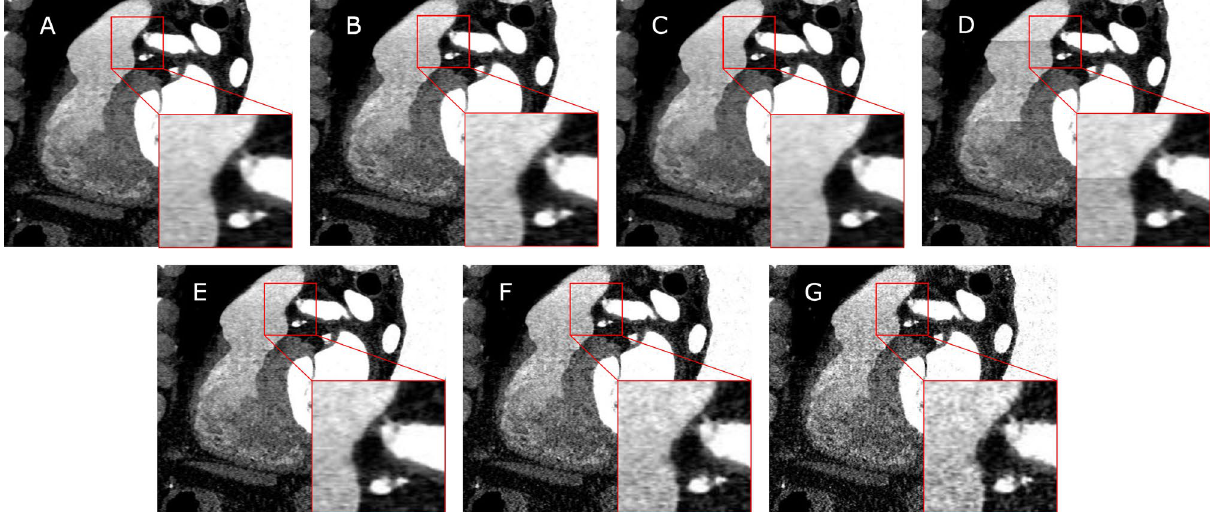
Figure 1. Sagittal views of a CCTA scan reconstructed with different parameters. The default configuration ( A ) reconstructed with an Advanced Modeled Iterative Reconstruction (ADMIRE) strength of 3, mixed stack and Bv36 kernel is varied by using: an ADMIRE strength of 2 ( B ) or 4 ( C ), using true stack ( D ) and utilizing a Bv40 ( E ), Bv44 ( F ) or Bv49 ( G ) reconstruction